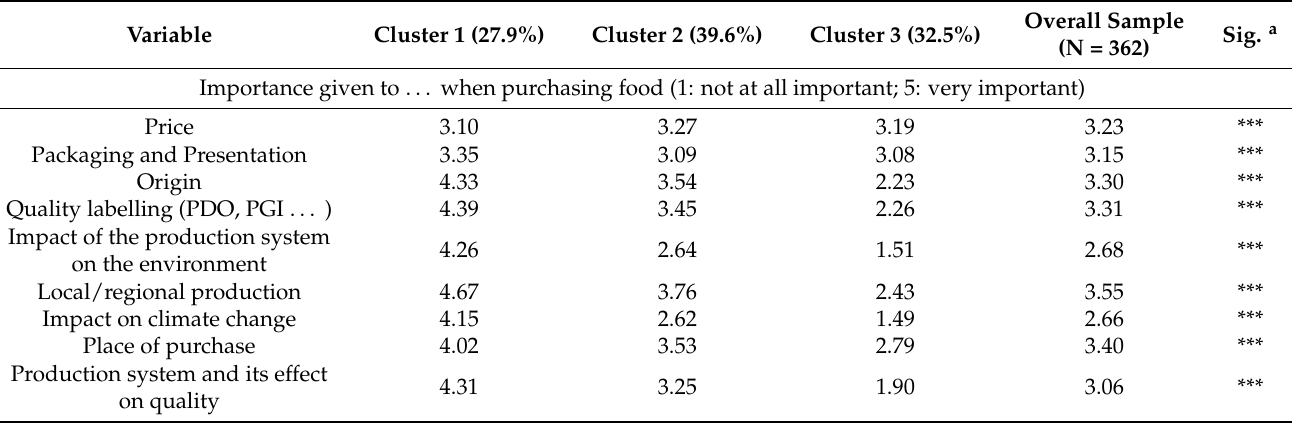
Table 4. Description of clusters and the overall sample in terms of attitudes and behaviour towards meat purchase and carbon